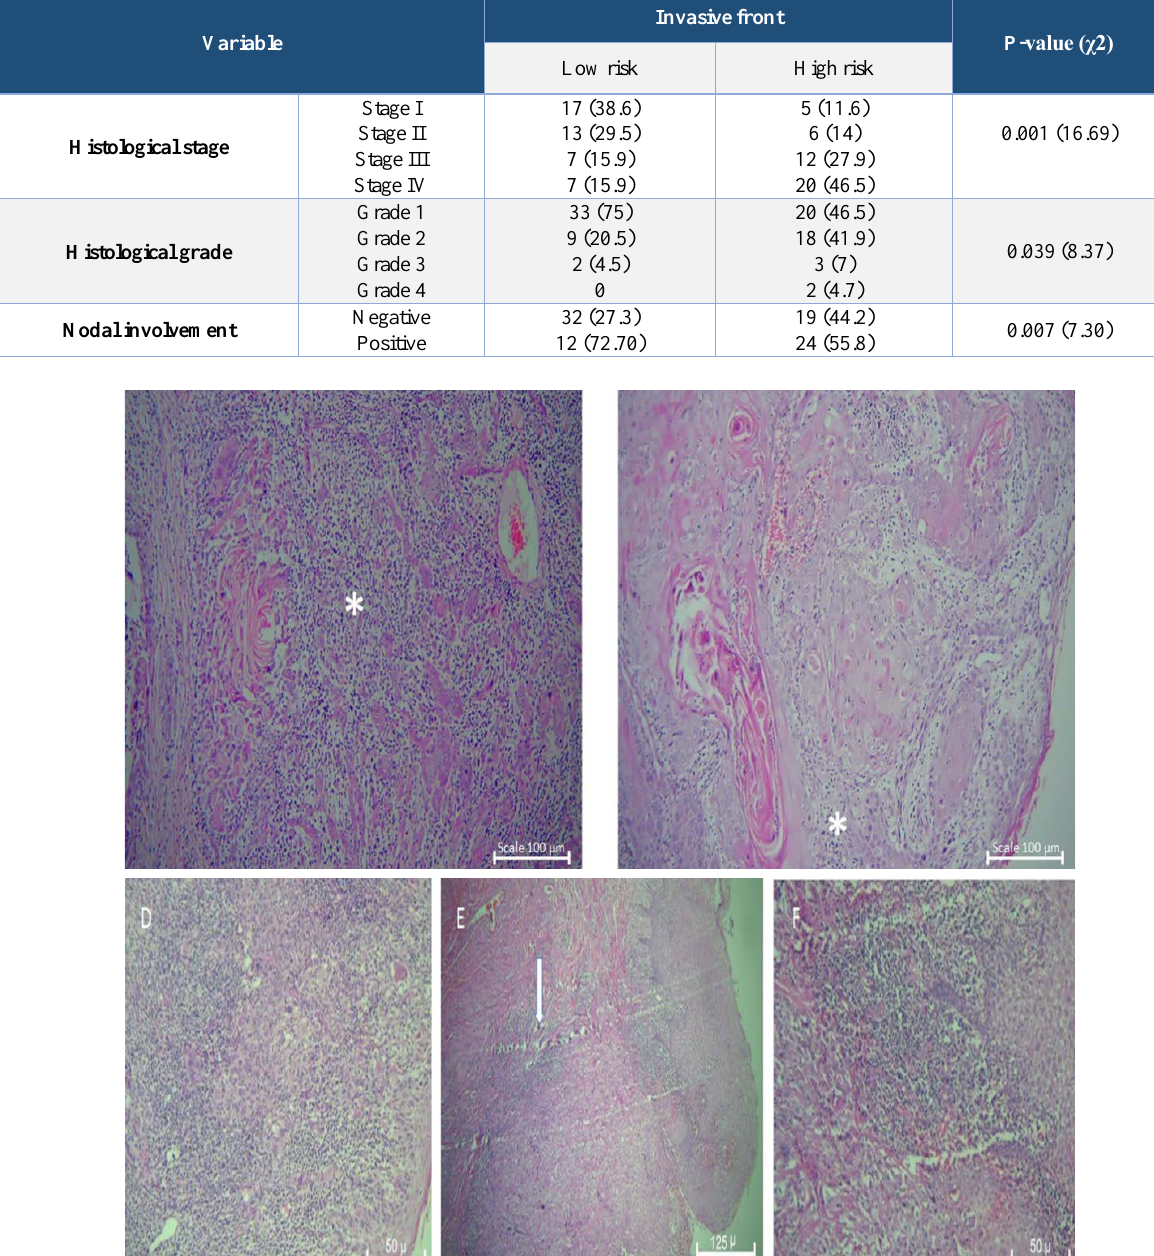
Fig. 2. A: High-grade SCC with sever chronic inflammatory infiltration (asterisk). X100, B: Low-grade SCC with mild to moderate chronic inflammatory infiltration (asterisk). X100 F: X100 magnification of